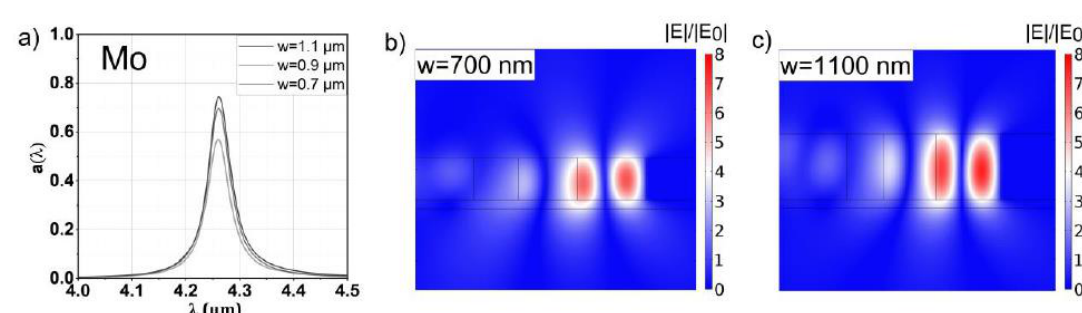
Figure 6. ( a ) Spectral response of the µ -GA optimized Mo-based STP structures for slab thicknesses of 0.7, 0.9 and 1.1 µ m, respectively, and a resonant wavelength of 4.26 µ m. The relative field enhancements of the thinnest (0.7 mm) and thickest (1.1 µ m) slab are shown in panels ( b , c ), respectively. The high Q factor of the resonance is reflected by a 6- to 8-fold enhancement of the electric field, similar to the resonance featuring Ag.